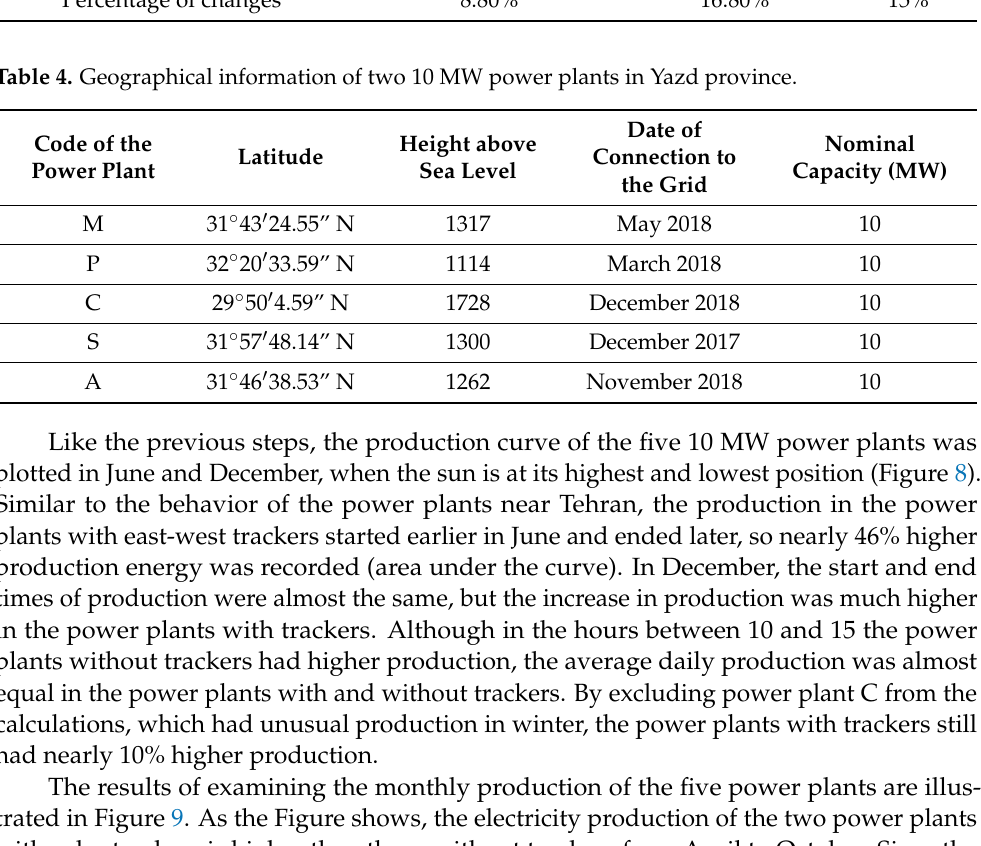
Table 3. A comparison between power plants average capacity factor, capacity credit and peak time overlap in power plants with/out trackers near Tehran. Q power plant (with a tracker) 73.60% T power plant (without a tracker)